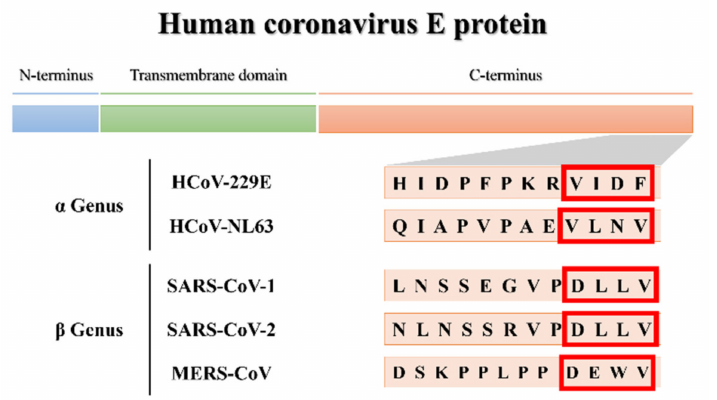
Figure 1. Partial C-terminus amino acid sequences of the human coronavirus (hCoV) envelope (E) proteins of the α - and β -CoV genera. Potential PDZ-binding motifs (PBMs) are indicated in the red